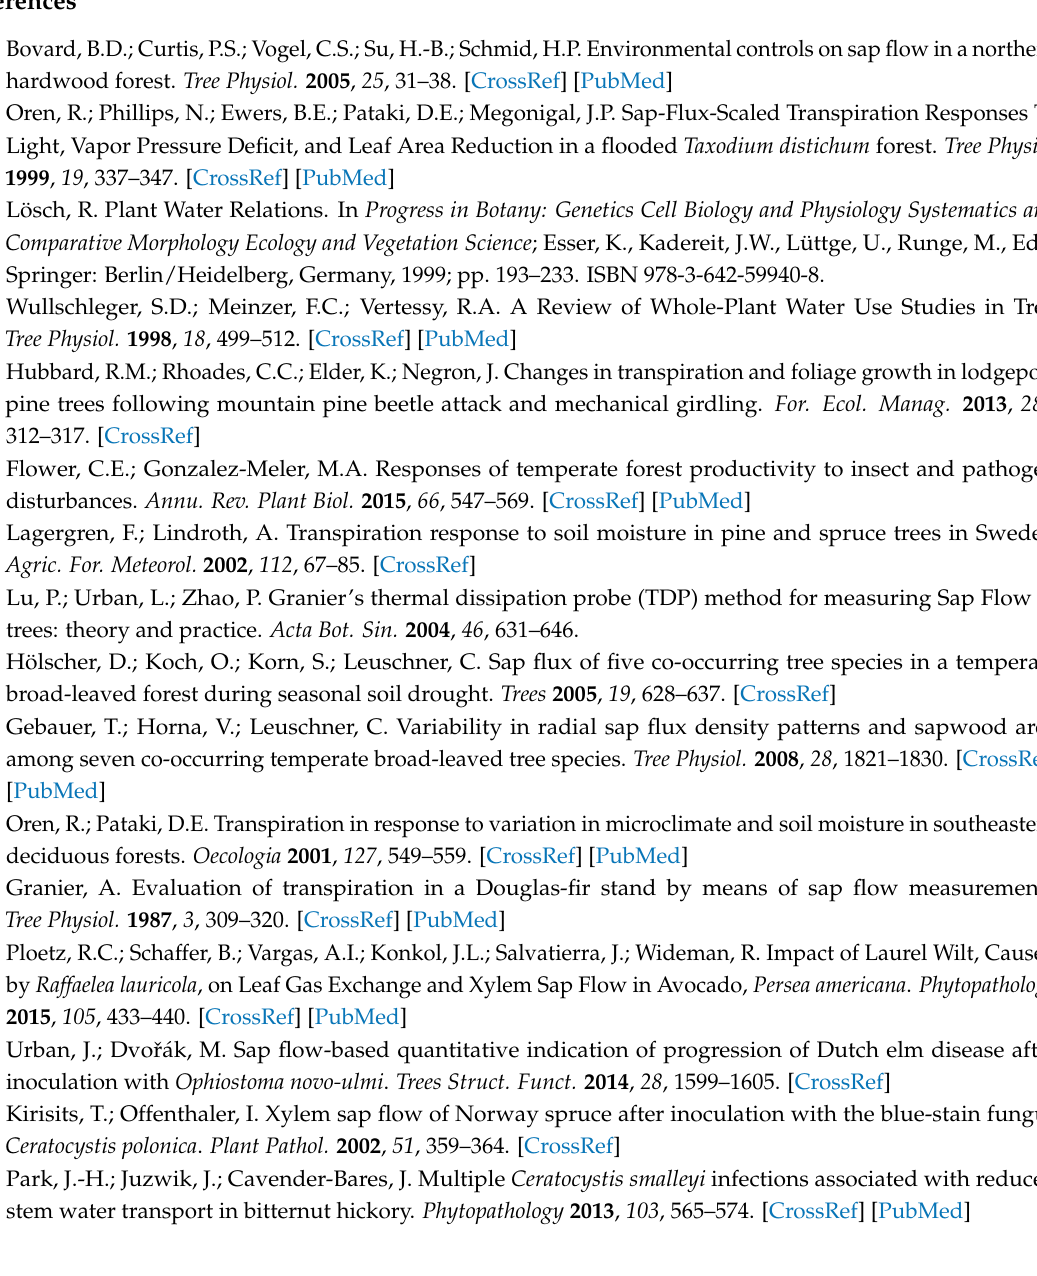
Figure S1: Relationship between leaf dry mass and surface area, Figure S2: Relationship between relative daily water use and relative canopy